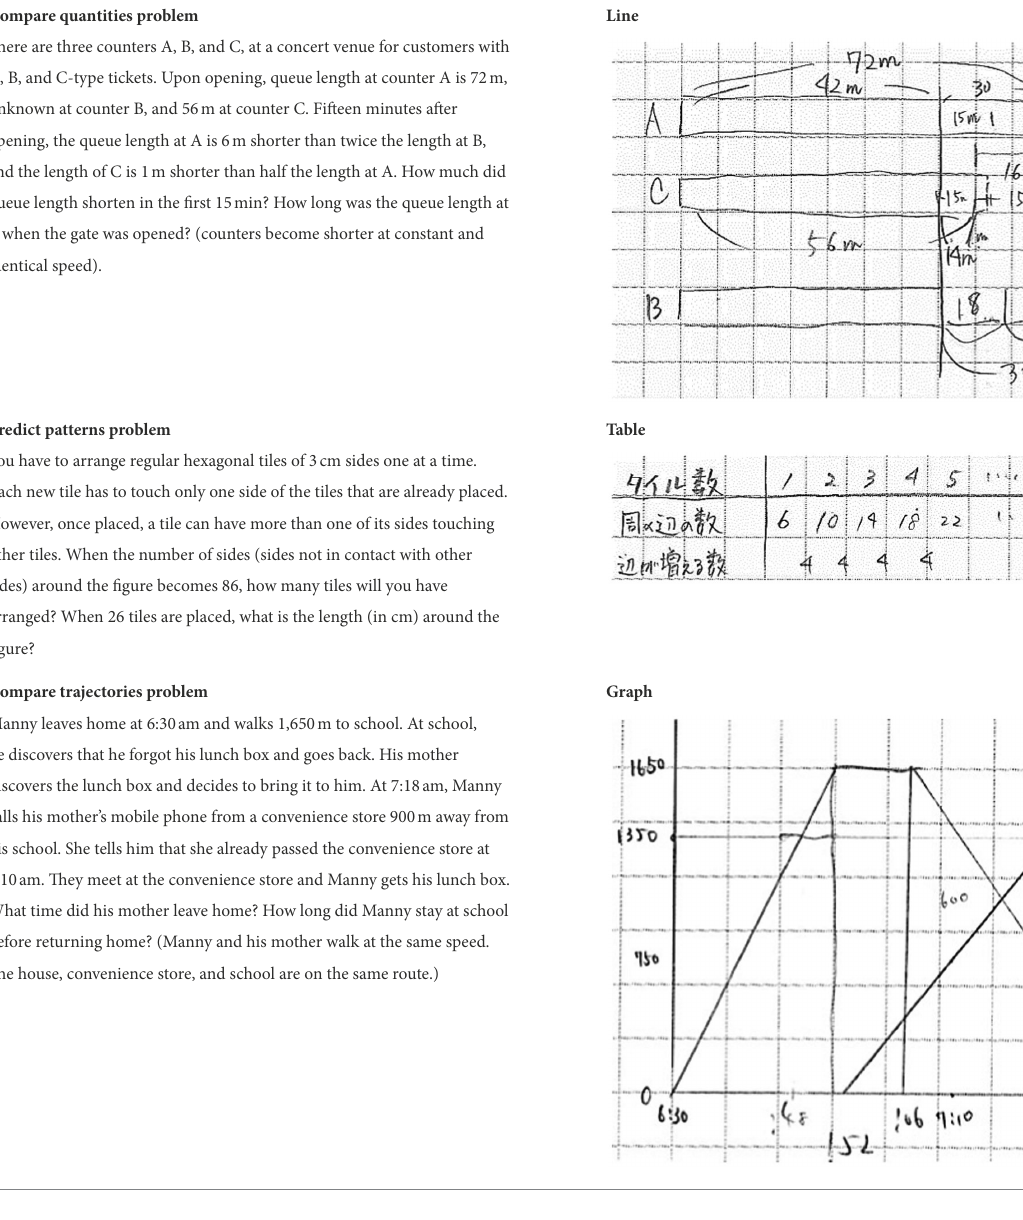
TABLE 1 Example problems (translated from Japanese) and student-constructed problem-appropriate diagrams. Compare quantities problem